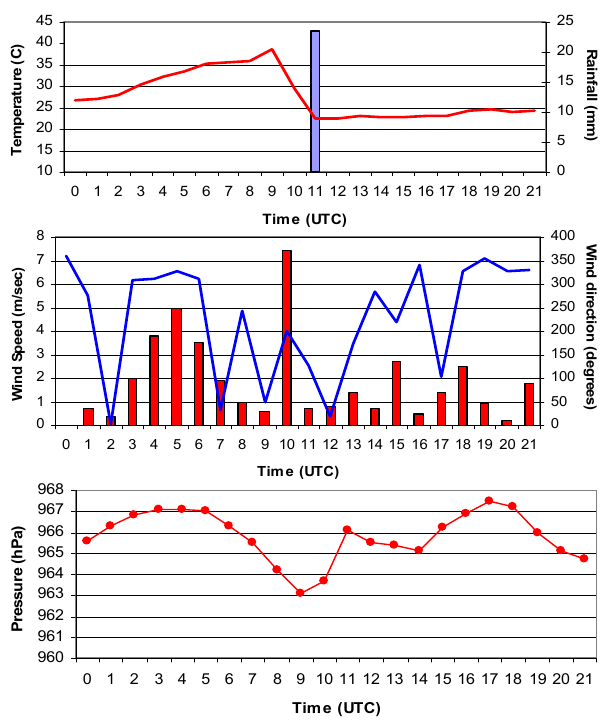
Fig. 3. Details of the thunderstorm observed over Gadanki on 21 May 2008. The top panel shows the variation of dry bulb tempera- ture (continuous line) and rainfall in mm (vertical bar). The middle panel shows variation of wind direction (line) and wind speed (ver- tical bars). The bottom panel shows the variation of surface pressure on 21 May